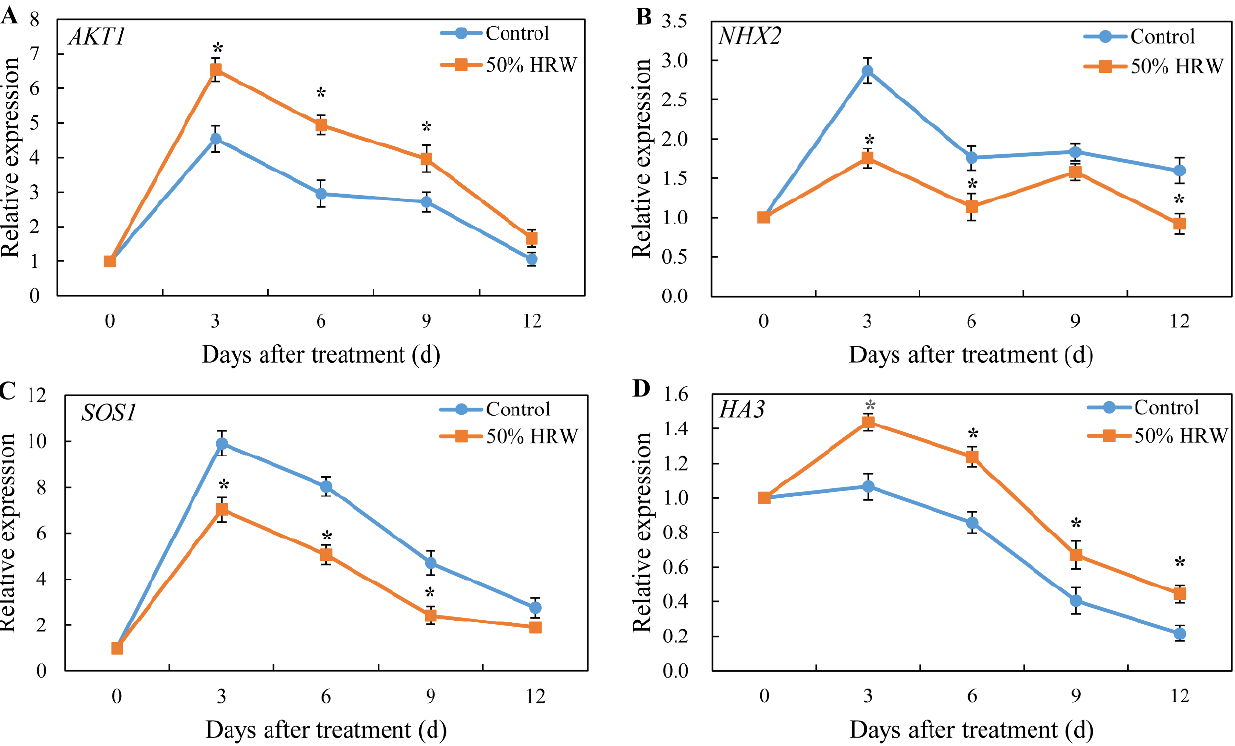
Figure 3. Expression of AKT1 ( A ); NHX2 ( B ); SOS1 ( C ); HA3 ( D ) genes in Lanzhou lily scales with or without 50% HRW treatment during storage at room temperature for 12 days. Values are the mean ± SE of three independent experiments. The asterisks denote T -test significance between the control and 50% HRW treatment on the same day: * p < 0.05. HRW: hydrogen-rich water. AKT1 : Inward rectifier potassium channel, NHX2 : Sodium/hydrogen exchanger family, SOS1 :